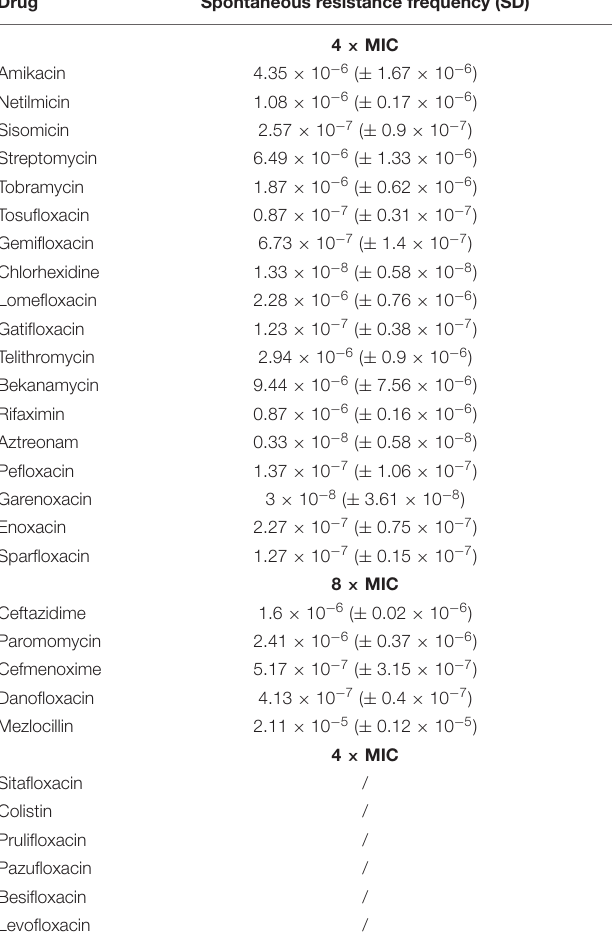
TABLE 2 | Spontaneous resistance frequencies of P. aeruginosa PAO1. Drug Spontaneous resistance frequency